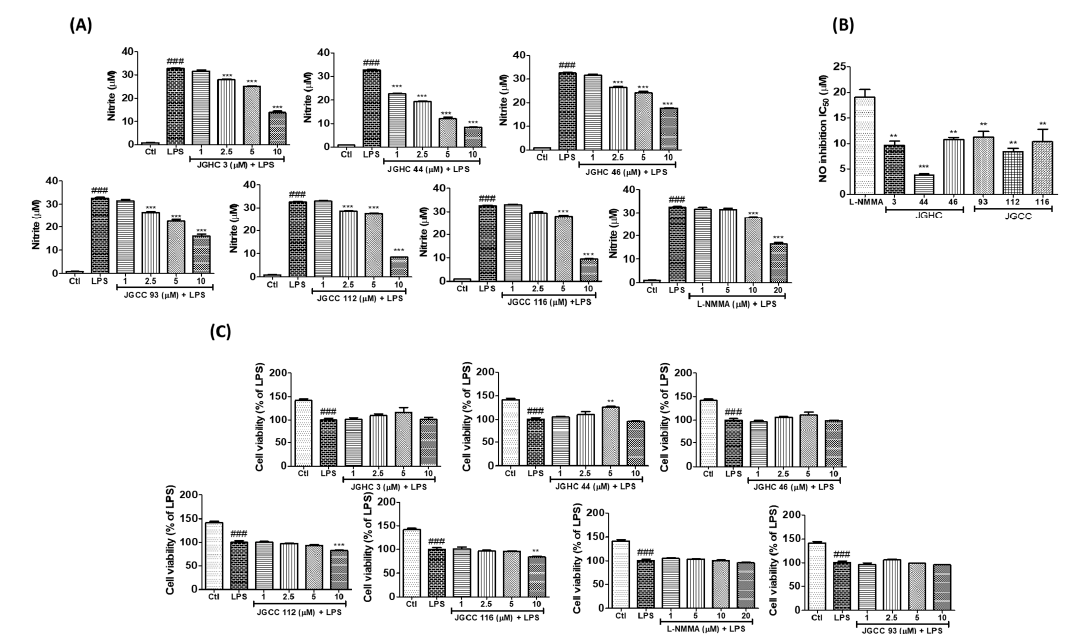
Figure 3. Active components from A. holophylla subfractions inhibited nitrite production without exhibiting cytotoxicity. BV2 cells were pre-treated with indicated concentrations of A. holophylla phytochemicals JHC 3, JGHCC 44, JGHC 46, JGCC 93, JGCC 112, and JGCC 116 followed by 100 ng/mL LPS activation for 24 h and nitrite production; cell viability was measured. ( A ) Phytochemicals inhibited nitrite production. ( B ) IC 50 values of phytochemicals that inhibited NO production. ( C ) Cell viability after phytochemical treatment in LPS-activated microglia. ** p < 0.01, and *** p < 0.001 indicate significant differences compared with treatment of LPS alone, while ### p < 0.001 indicates significant differences compared with the untreated control group. Ctl indicates untreated control cells, LPS indicates LPS-treated cells.